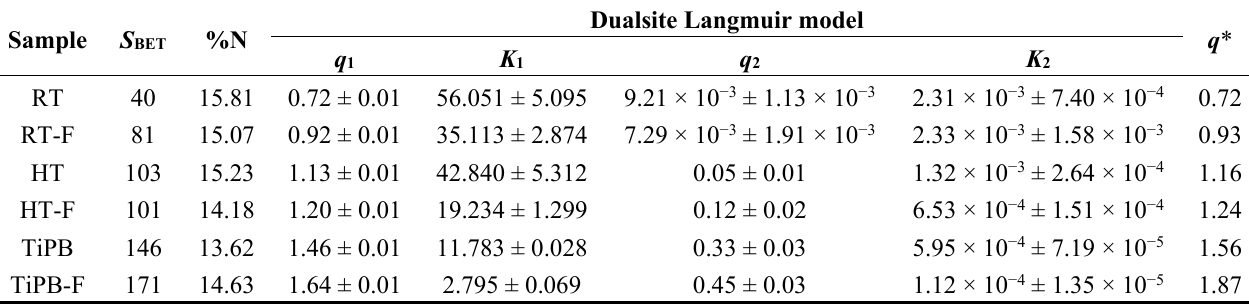
Table 5. Parameters from fit to Dualsite Langmuir model for amine impregnated samples (50% polyethylenimine ethylenediamine branched (PEI)).